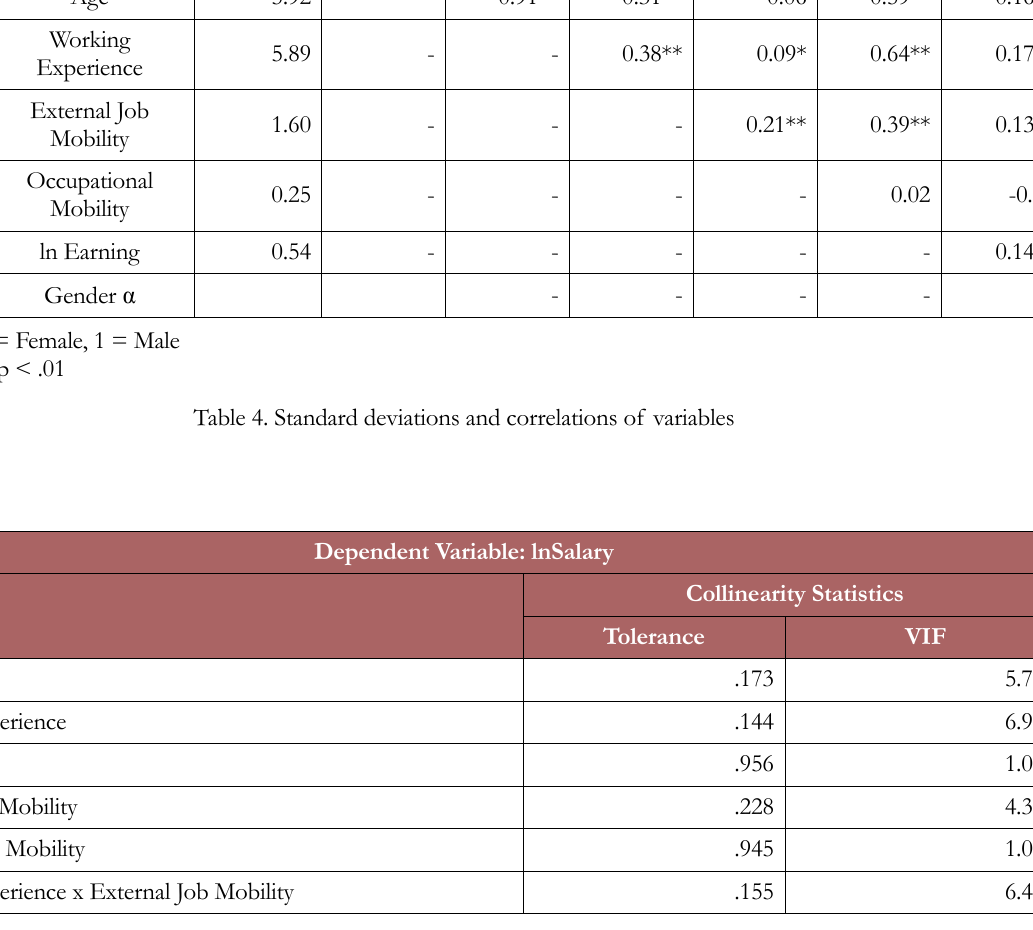
Table 5. Collinearity Statistics - Model